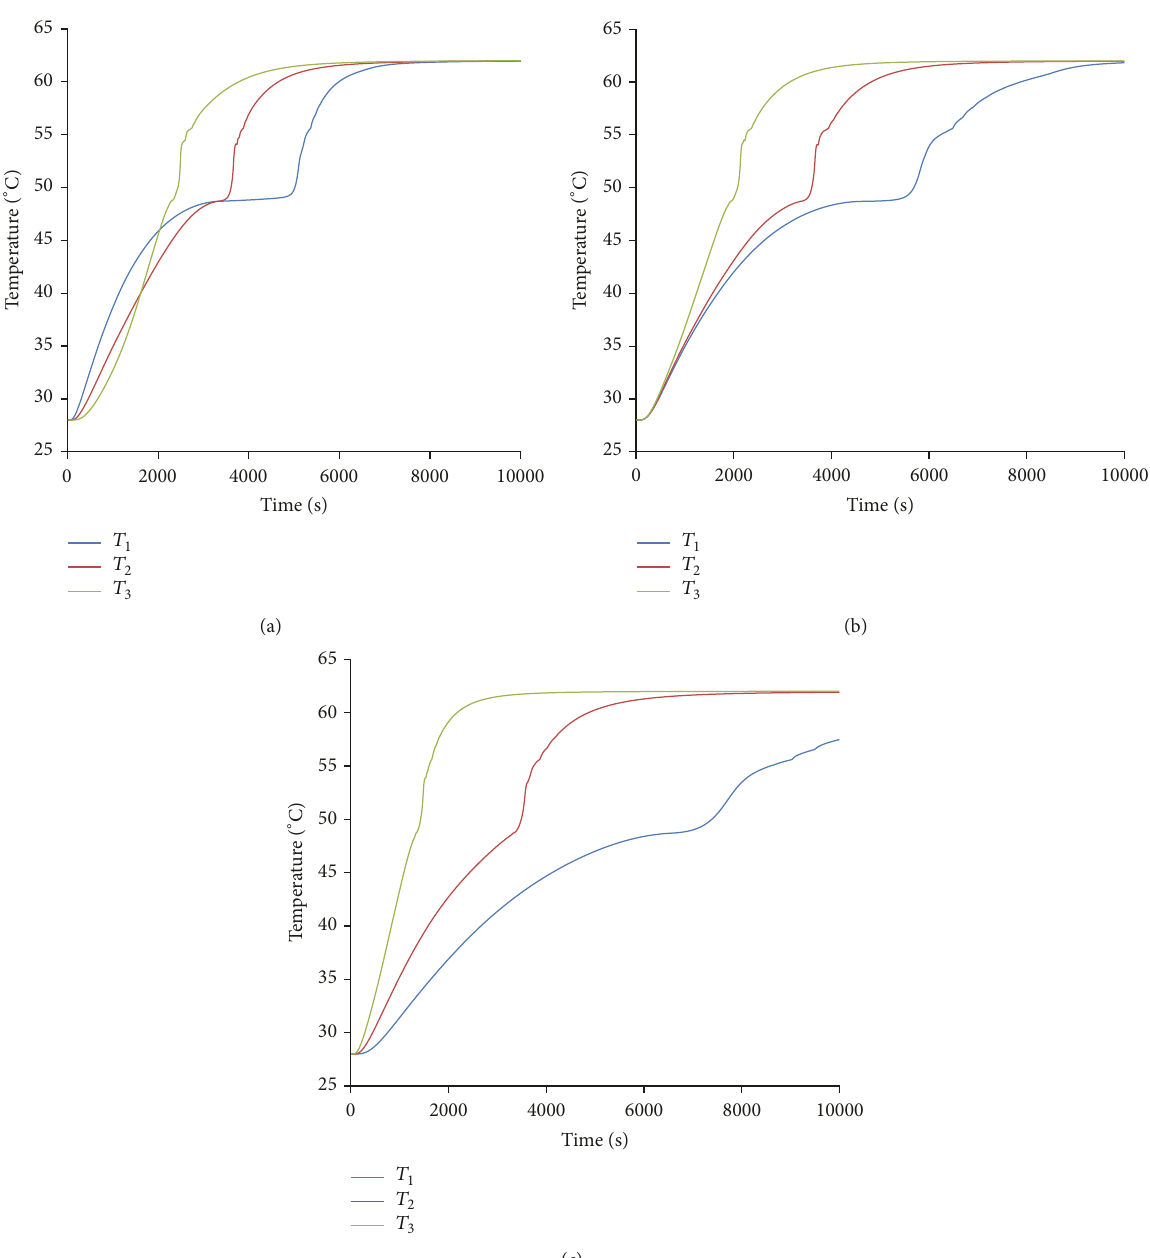
Figure 7: The temperature distribution of the paraffin: (a) nozzle-and-shell, (b) tube-and-shell, and (c) reducer-and-shell models.